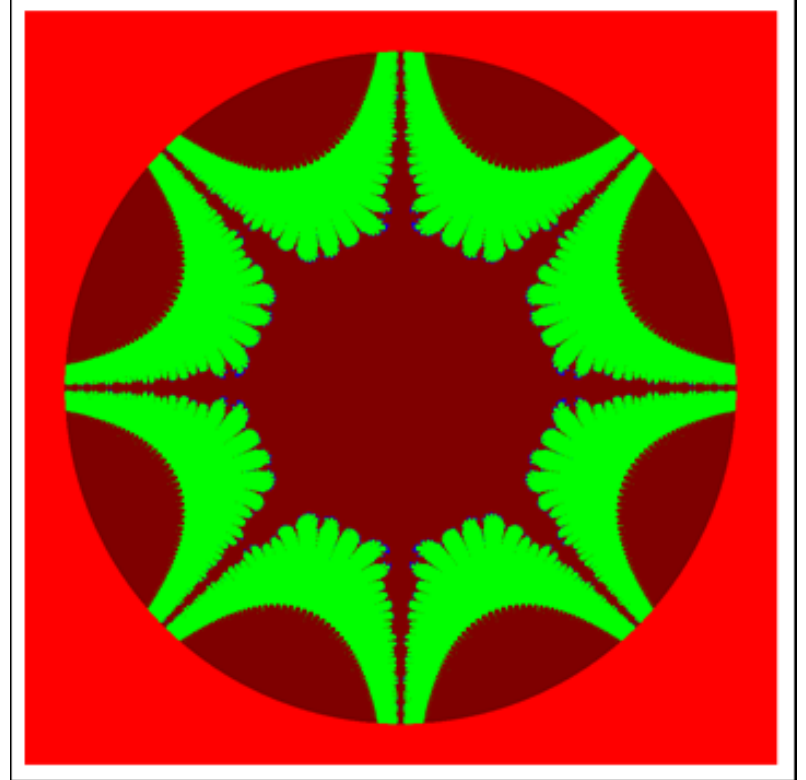
Figure 9. J-set for τ ( z ) = sin ( z 4 ) + c via DKIS. The image execution time is 305.454